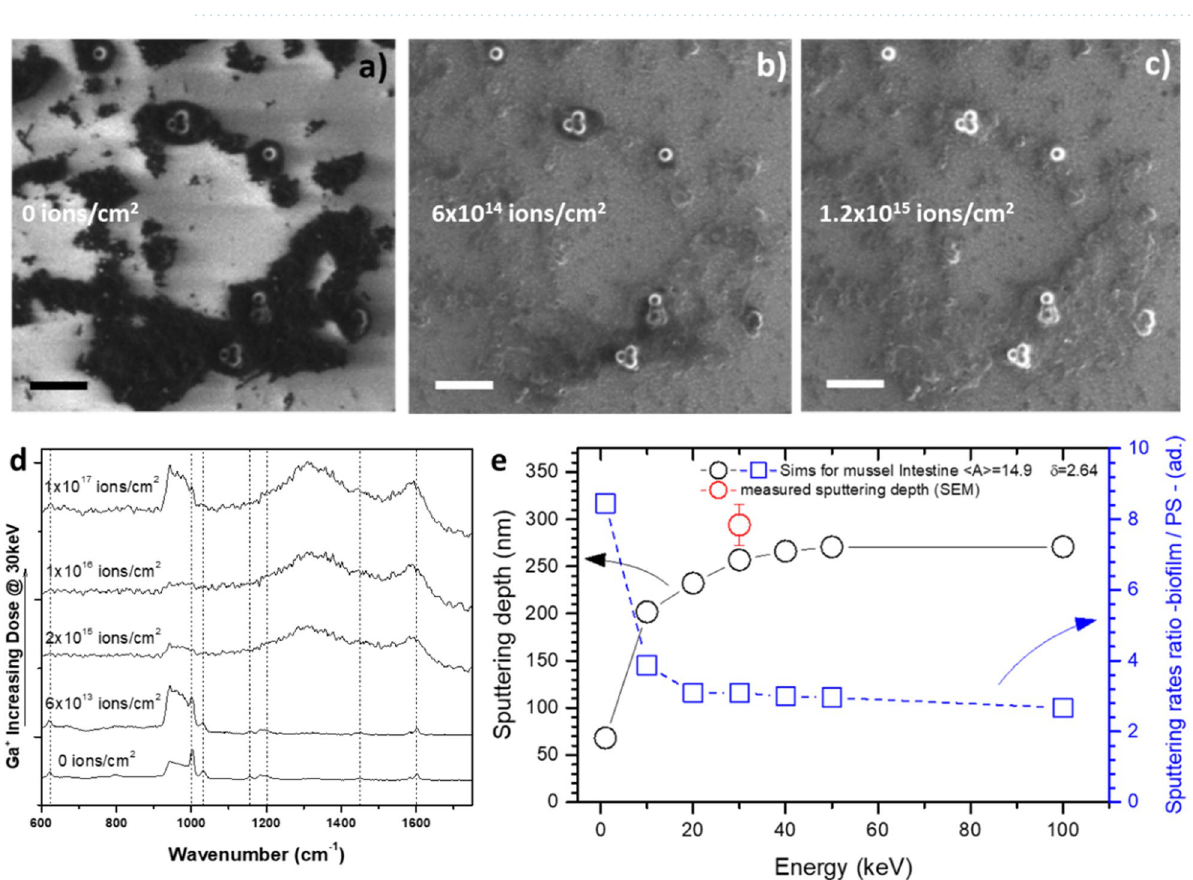
Figure 5. ( a ) SEM image of mussel matrix and the PS-NP casted on a silicon chip ( b ) same image of ( a ) with a dose of 6 × 10 14 Ga + ions ( c ) same image of ( a ) with a dose of 1.2 × 10 15 Ga + ions. ( d ) Evolution of the confocal Raman spectra as a function of the Ga + ions dose ( e ) SRIM calculation of the sputtering depth for the mussel matrix and of the sputtering ratio between mussel matrix and the pNP as a function of the acceleration voltage of the ions. Scale Bar is 500